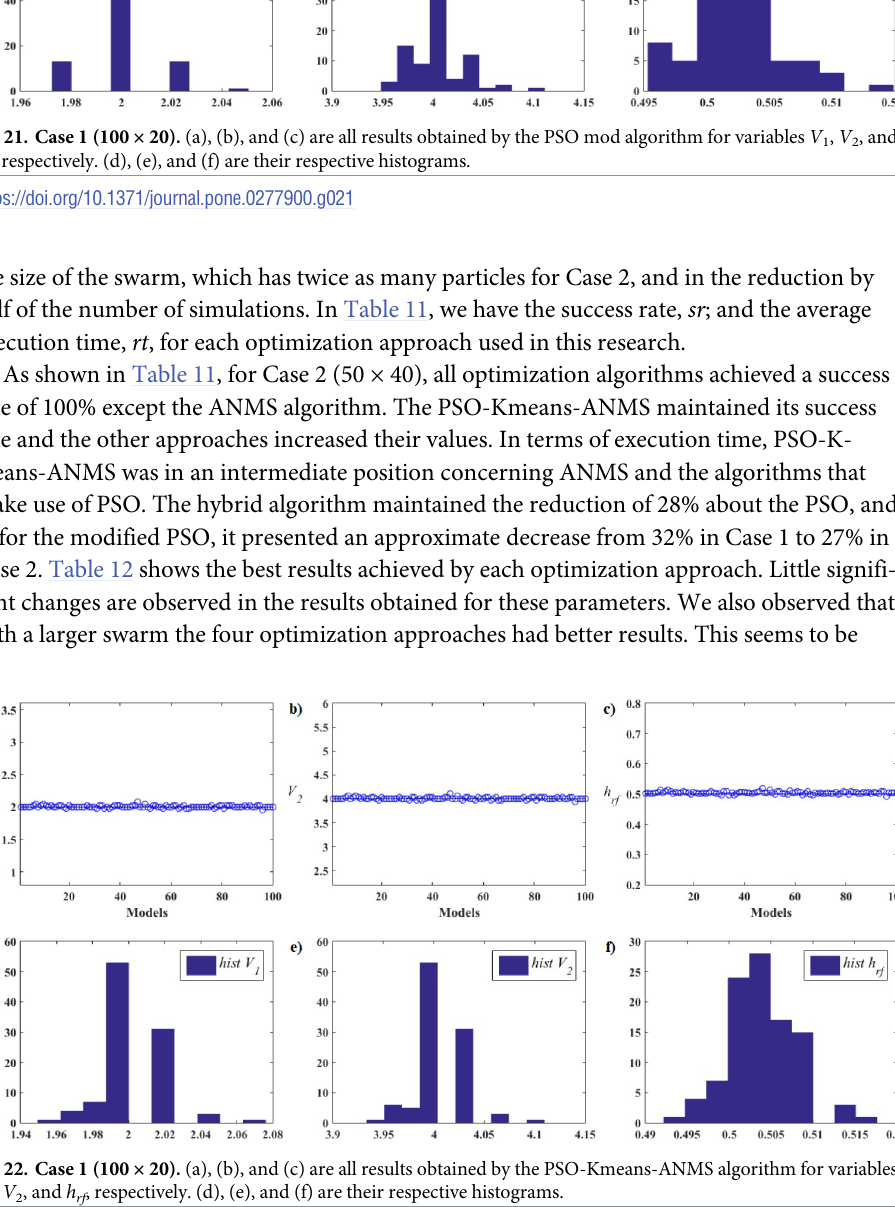
the size of the swarm, which has twice as many particles for Case 2, and in the reduction by half of the number of simulations. In Table 11, we have the success rate, sr ; and the average